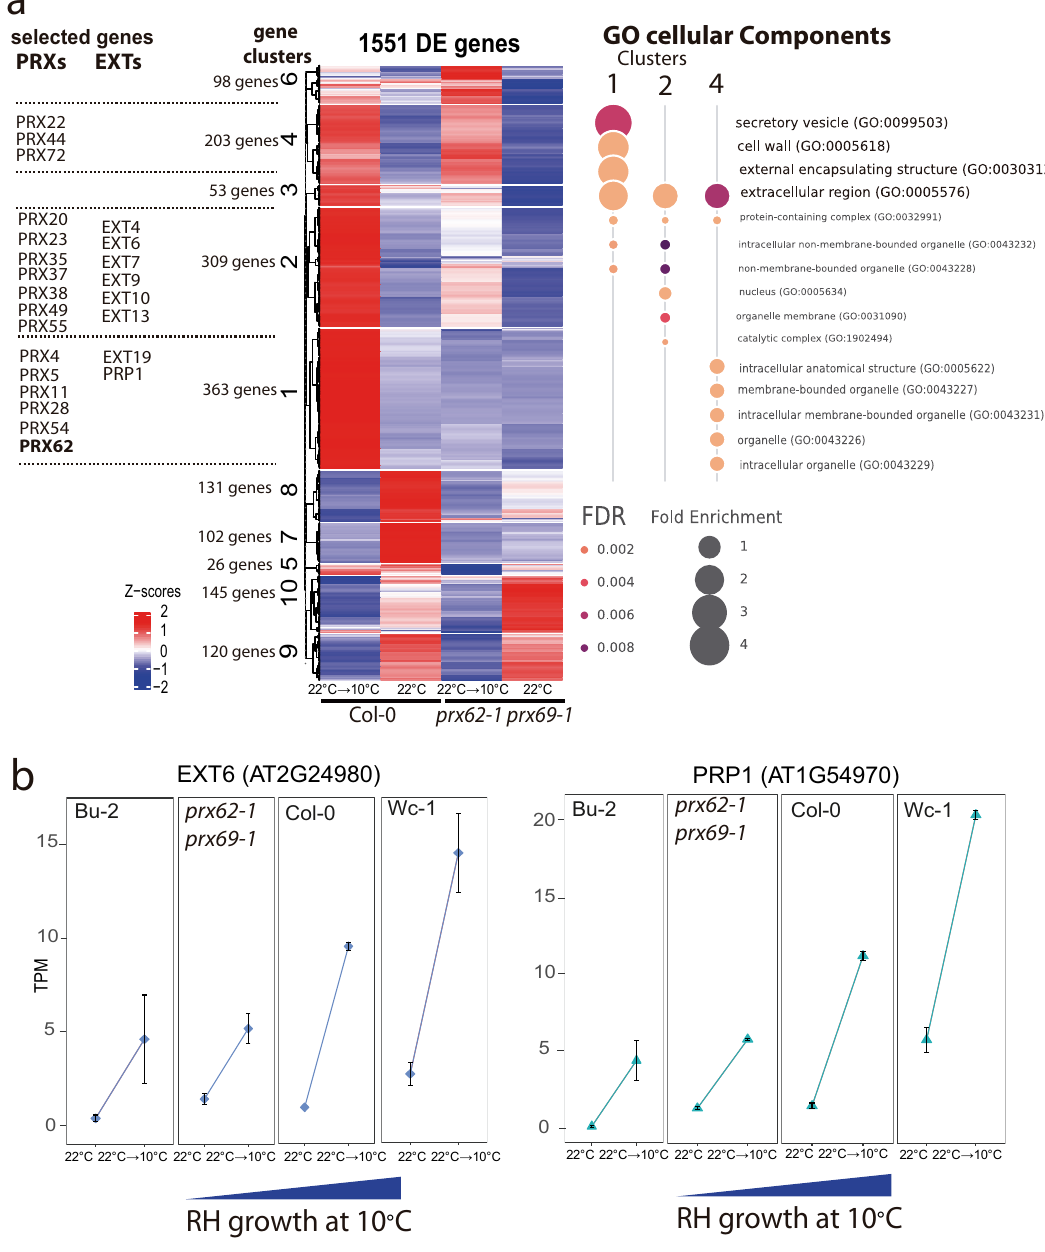
Fig. 4 Global transcriptomic changes induced by low temperature and misregulated in the prx62-1 prx69-1 mutant are associated with PRXs and cell associated-EXTs. a Heat-map showing the hierarchical gene clustering for 1551 A. thaliana genes differentially expressed (DE) between room temperature growth (22 °C) and low temperature (10 °C) growth in wild type Col-0 and in double mutant prx62-1 prx69-1 roots. Gene Ontology analysis results depicting the top 7 most signi fi cantly enriched GO terms are shown as bubble plots on the right for the clusters of interest. DE genes in clusters 1, 2 and 4 were contrasted against all the expressed genes for GO analysis. The size of the points re fl ects the amount of gene numbers enriched in the GO term. The color of the points means the p -value. Relevant gene examples of speci fi c clusters (1, 2, and 4) are listed on the left. b Expression of EXT6 and PRP1 is gradually upregulated at low temperature (10 °C) in 4 genotypes from very short RHs (Bu-2) to very long RHs (Wc-1) (RNA-seq data). TPM = Transcripts Per Kilobase